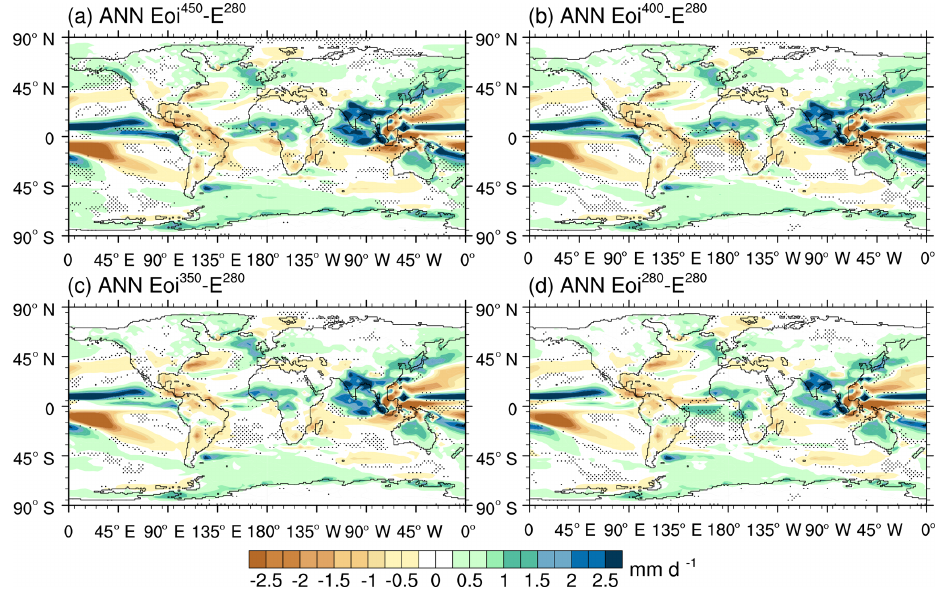
Figure 5. Pliocene mean annual precipitation anomalies against E 280 . (a) Eoi 450 –E 280 , (b) Eoi 400 –E 280 , (c) Eoi 350 –E 280 and (d) Eoi 280 – E 280 . Stippling indicates regions in which results are not statistically significant at a 95% confidence criterion.